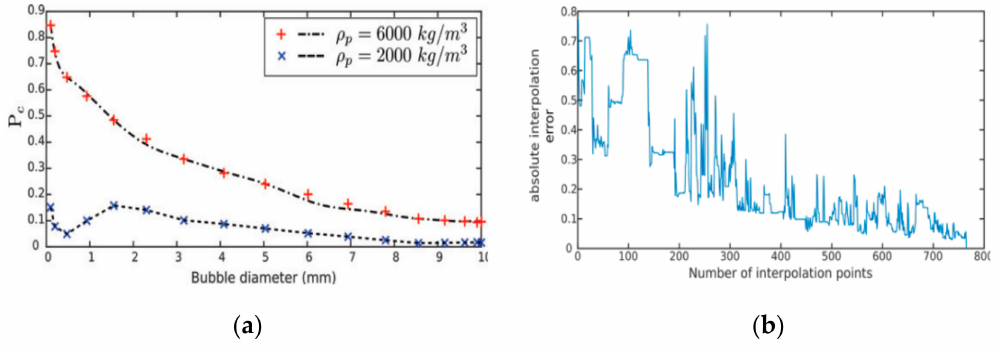
Figure 11. ( a ) Bubble–particle collision probability, P c , versus bubble diameter, ( b ) prediction absolute error versus number of interpolation points